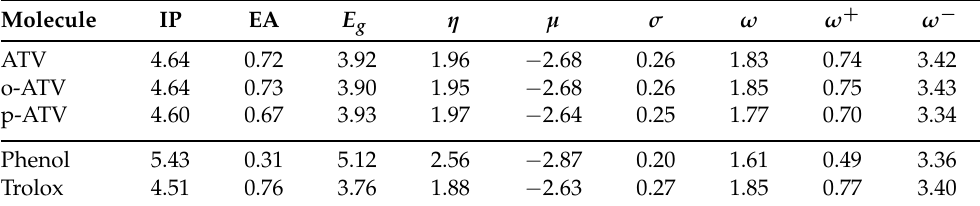
Table 1. Global chemical reactivity indices (eV) computed via B3LYP/6-31+G(d,p)/IEFPCM for atorvastatin and its ortho- and para-hydroxy metabolites and two natural oxidants in methanol. Molecule IP EA